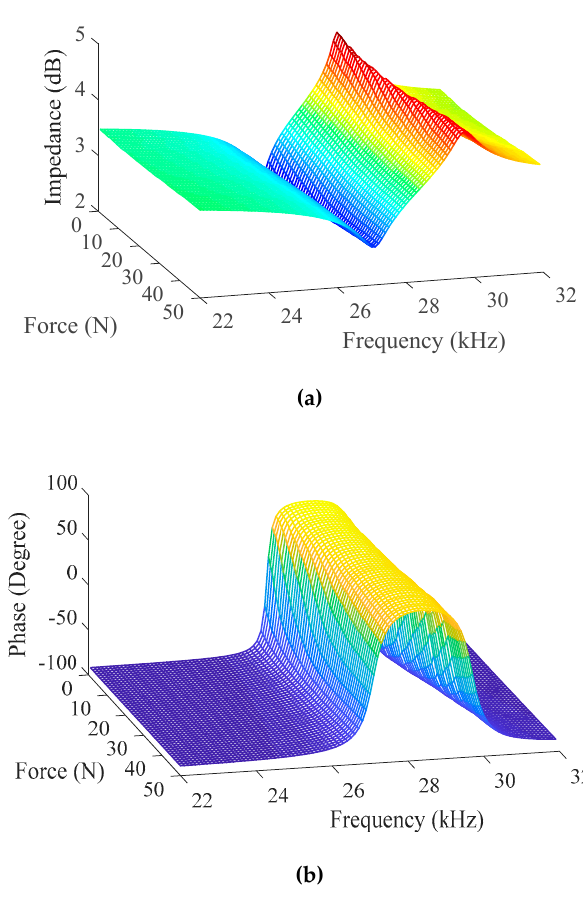
Figure 10. Impedance and phase with different loads. ( a ) Impedance; ( b ) Phase.